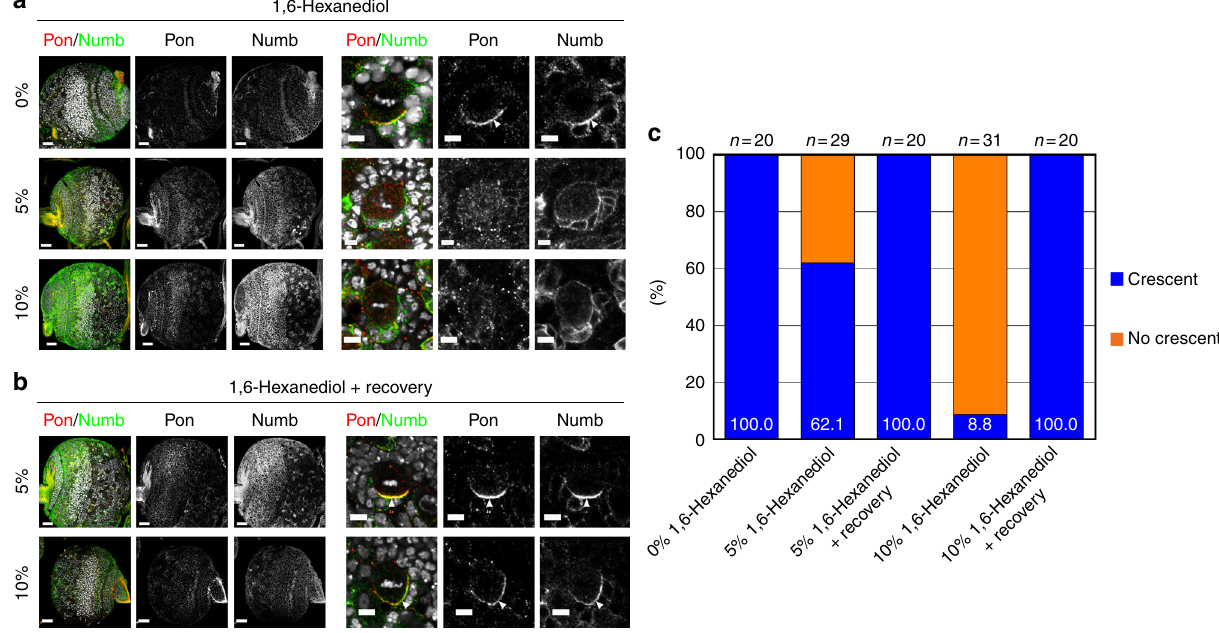
Fig. 9 The basal localization of Numb and Pon is disturbed by 1,6-hexanediol in dividing NBs of larval brains. a In wild-type NBs treated with 5% 1,6- hexanediol, some (37.9%) NBs exhibit cytoplasmic localization of Pon and cortical localization Numb. When treated with 10% 1,6-hexanediol, virtually all NBs show cytoplasmic Pon and cortical Numb. b After removal of 1,6-hexanediol, the basal distribution of Numb/Pon is restored in NBs pre-treated with hexanediol. ToPro-3 in white. White arrowheads point to basal cortex. Scale bars, 25 µ m for the whole brain and 5 μ m for NB images. c Statistical data for a and